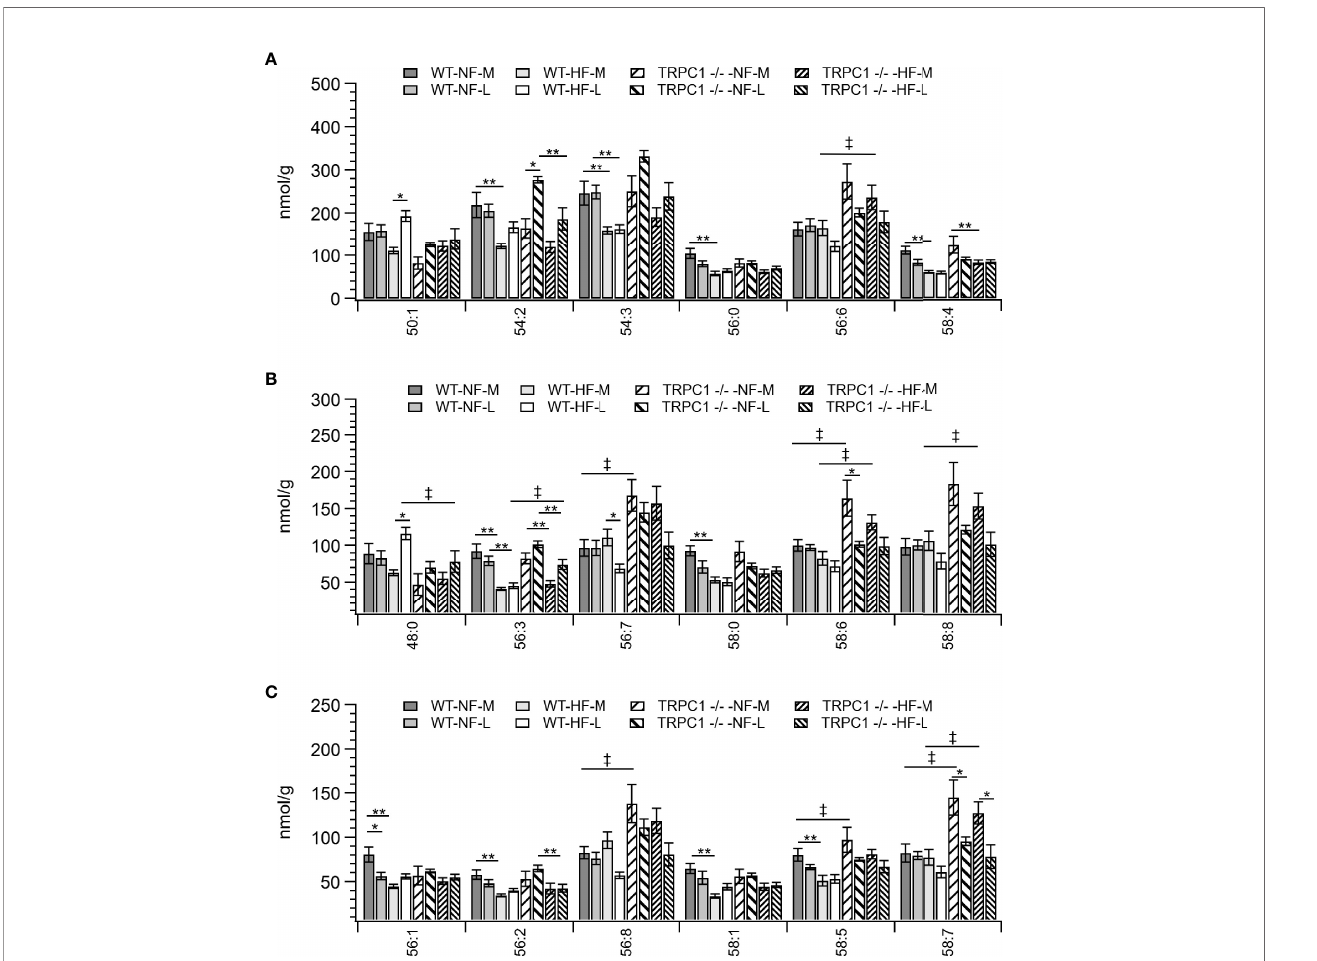
FIGURE 4 | Placental TAG concentration by species for TAG C:N. C = acylcarbon number and N = acyl desaturation level.Species are grouped with diminishing concentrations from A – C to illustrate the range of concentrations. Data are shown as mean ± sem (n = 16, exceptfor HF-TRPC1 where n = 12). Symbolsindicate differences with p<0.05 base upon one-way ANOVA with Tukey ’ s HRD post hoc test and application of a 0.05 false discovery rate for gestational age (*), diet (**), and genotype ( ‡ ). P- values areavailablein Supplemental Materials . WT, wild-type; TRPC1 -/-, TRPC1 knock-out; NF, normal fat diet; HF,high-fat diet; M, mid-gestation;L,late